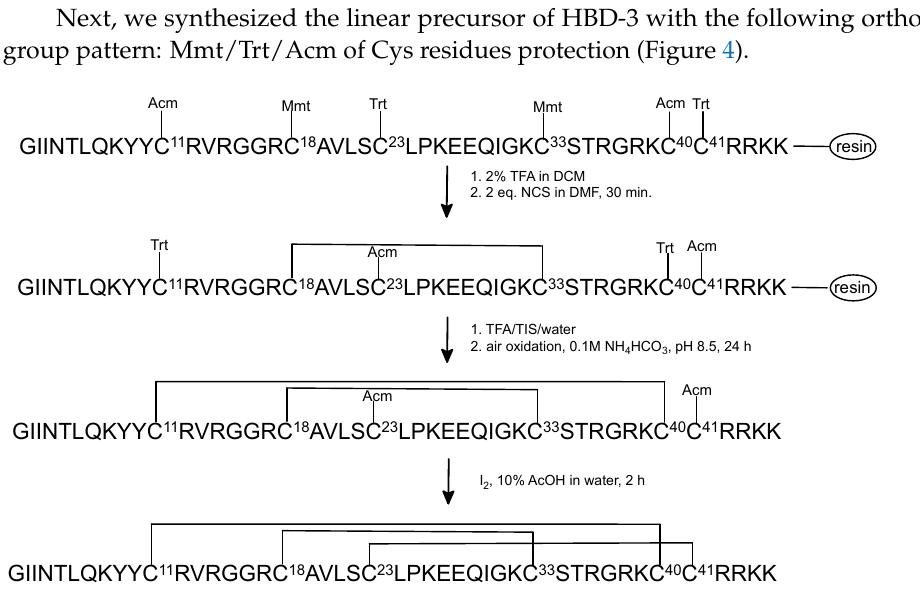
Figure 4. The scheme of regioselective oxidative folding of HBD-3 with Mmt/Trt/Acm orthogonal Cys protection.